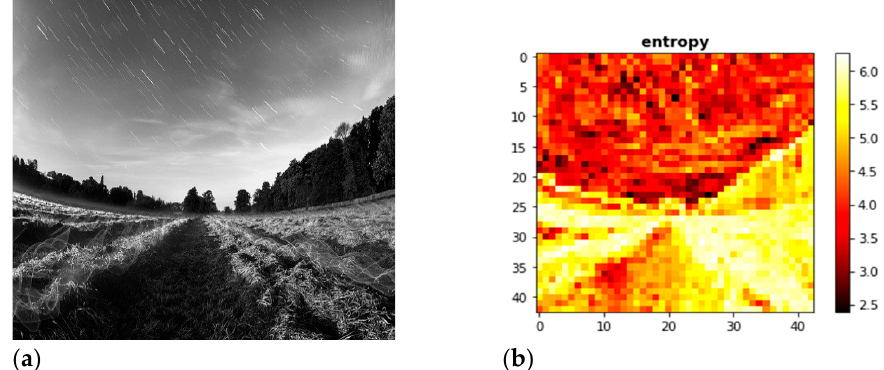
Figure 6. Correlation analysis: frames. ( a ) the input images, ( b ) the entropy of the image. The “lena” photo from Table 3, which has been encrypted with a sampling ratio of Table 3. Correlation coefficients between adjacent pixels of plain images and cypher images. 56.25, is used in the test to determine how sensitive the key is. Figure 7 depicts the image Image Horizontal Vertical Diagonal after it was rebuilt using erroneous keys that had a factor of 1014 difference between them.